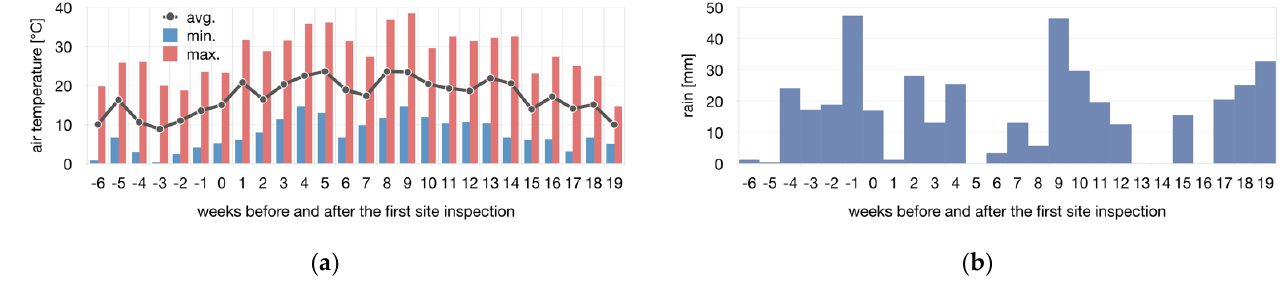
Figure 3. Dataset of the external weather station in weeks before and after the first site inspection: ( a ) average, minimum, and maximum temperatures per week; ( b ) accumulated rainfall per week. Data obtained from [39].